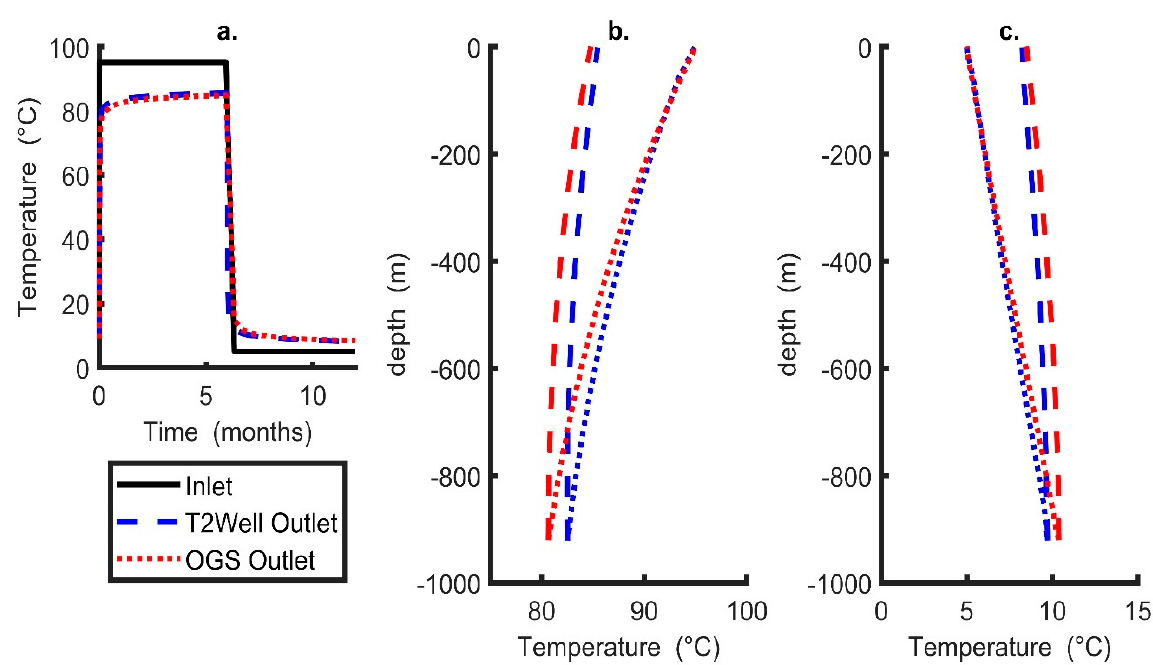
Figure 4. Comparison between OpenGeoSys (OGS) and T2Well-EOS1/TOUGH2 for the initial charge scenario. ( a ) Inlet and outlet temperatures for the different software, ( b ) comparison of the vertical profile with depth at the end of charge and ( c ) comparison of the vertical profile at the end of the extraction period. Note that the dashed line in ( b , c ) is the central pipe, whilst the dotted line is for the annular space. For the first 6 months of charge a constant inlet temperature of 95 °C was applied and for the subsequent 6 months of discharge an inlet temperature of 5 °C was used.